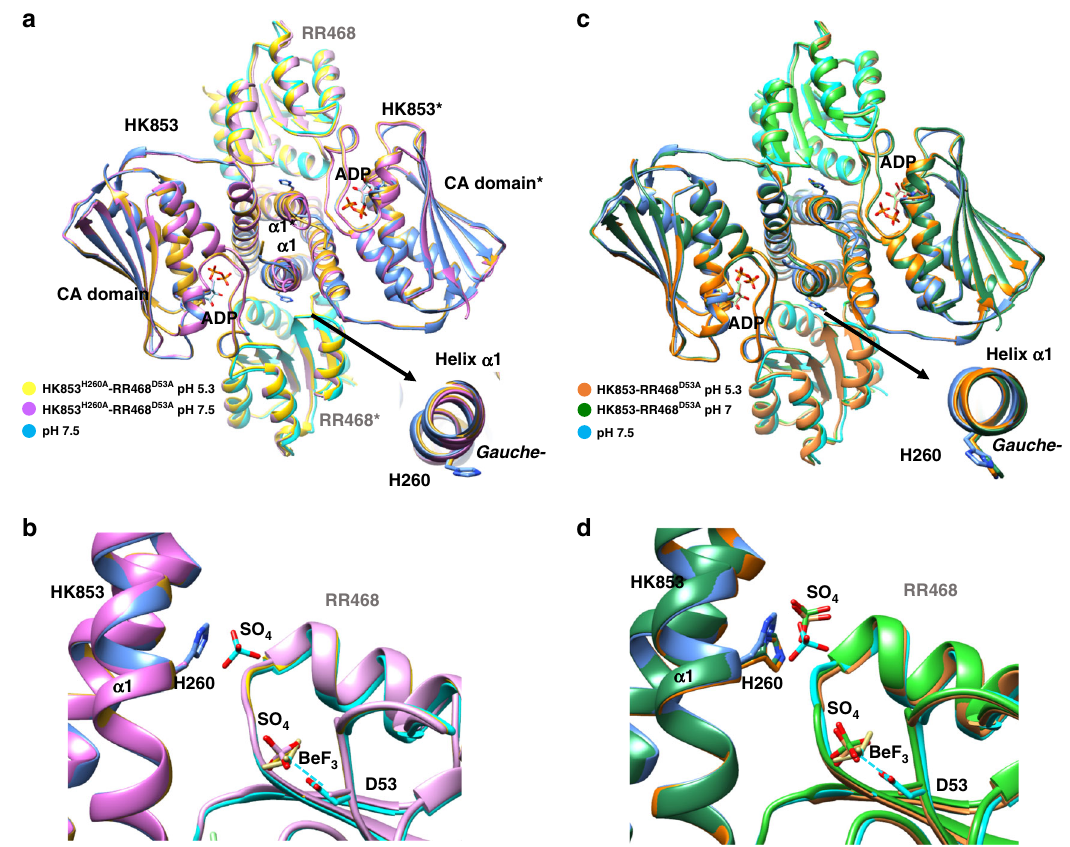
Fig. 3 Structures of complexes mutated in the phosphorylatable residues at different pHs. a Superposition of wild-type HK – RR pHs structure at pH 7.5 (blue tones) with HK853 H260A – RR468 D53A at pH 5.3 (yellow tones) and at pH 7.5 (purple tones). Structures are represented in cartoon with HKs and RRs in dark and pale hues, respectively. b Close view of the active center of superposed structures in a showing absence in the HK853 H260A – RR468 D53A structures of sulfate ion bound to H260 due to mutation to Ala. The sulfate ion in HK – RR pHs structure at pH 7.5 is shown as sticks with sulfur and oxygen atoms in cyan and red, respectively. Oppositely, a sulfate ion (in stick with sulfur atom in magenta and labeled as SO 4 ; the two negative charges of the anion have been omitted for clarity) is found at the active center of RR468 in the HK853 H260A – RR468 D53A structures at similar position than phosphomimetic BeF 3 − (in yellow sticks, labeled as BeF 3 ) despite absence of Asp53 due to mutation to Ala. c Superposition of wild-type HK – RR pHs structure at pH 7.5 (blue tones) with HK853 – RR468 D53A at pH 5.3 (orange tones) and at pH 7 (in blue). d Close view of the active center of superposed structures shown in c highlighting the presence of the sulfate ion bound to H260 (in stick with sulfur atom colored in similar tone as the corresponding molecule). A second sulfate ion (in stick with sulfur atom colored in similar tone as the corresponding molecule) bound at similar position than phosphomimetic BeF 3 − (in yellow sticks) is found in the RR468 active center of HK853 – RR468 D53A despite absence of